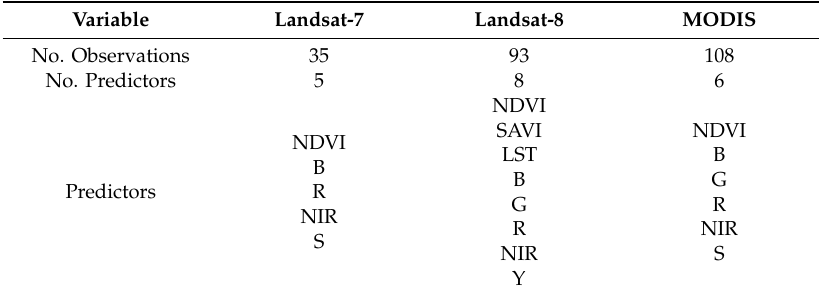
Table 3. Number of observations and predictors per satellite to build the LUR models.